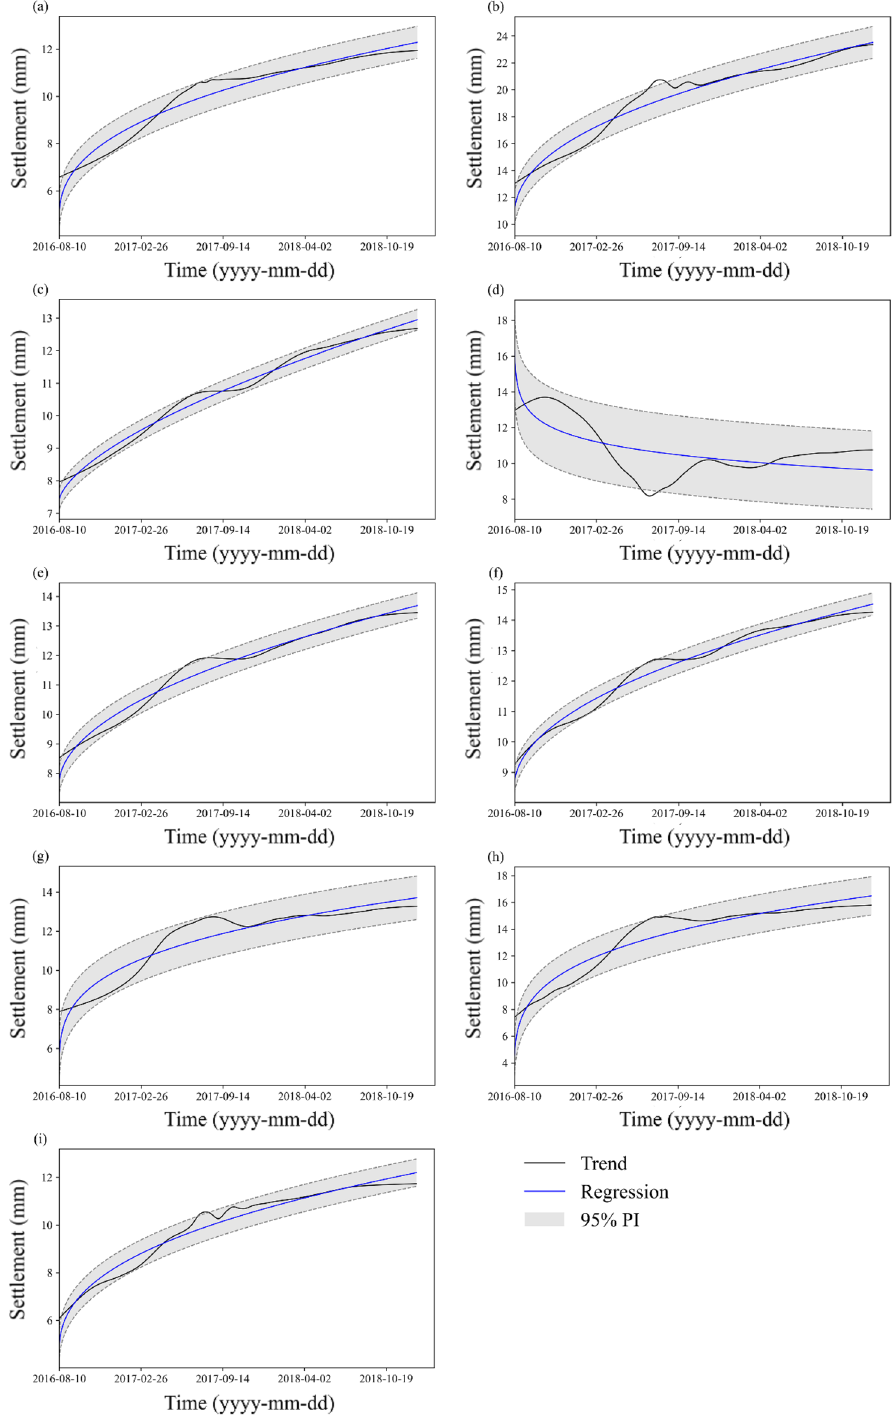
Figure 6. 95% prediction interval of the regression model: ( a ) TP1-1; ( b ) TP1-2; ( c ) TP1-3; ( d ) TP2-1; ( e ) TP2- 2; ( f ) TP2-3; ( g ) TP3-1; ( h ) TP3-2; and ( i )